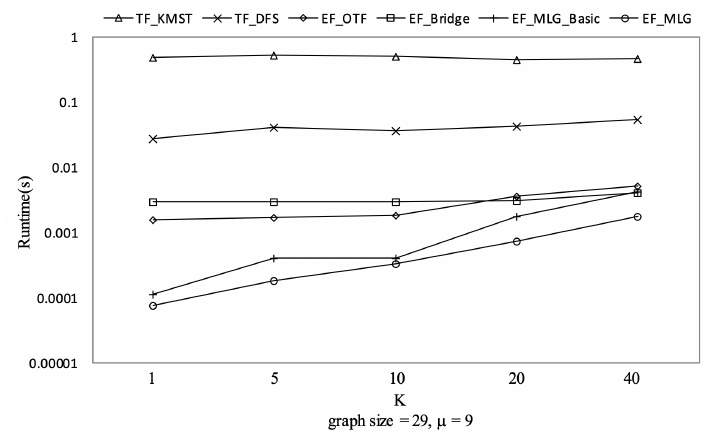
Figure 19. Runtime on Ncfu vs. k with graphsize = 29 and µ = 9. Experiment 3. Experiment 3 evaluated the performance on GraphGen and Ncfu when µ changed.